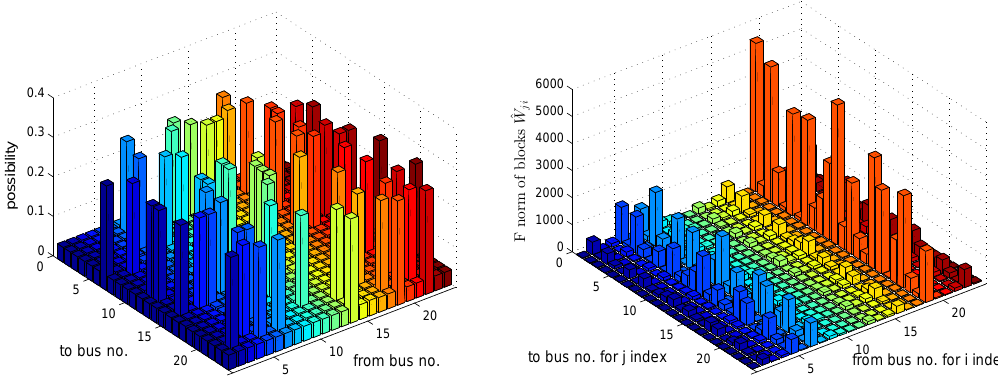
Figure 7. Optimal DoS attacks and control structure 3D graph in the IEEE 24 bus